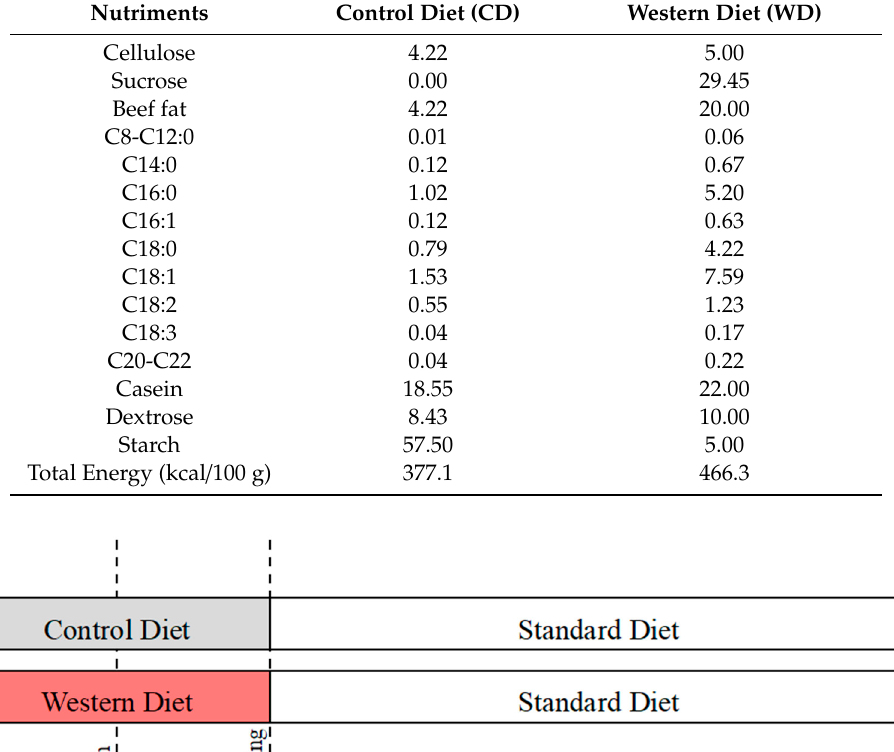
Table 4. General diet in compositions (expressed in % of kcal).